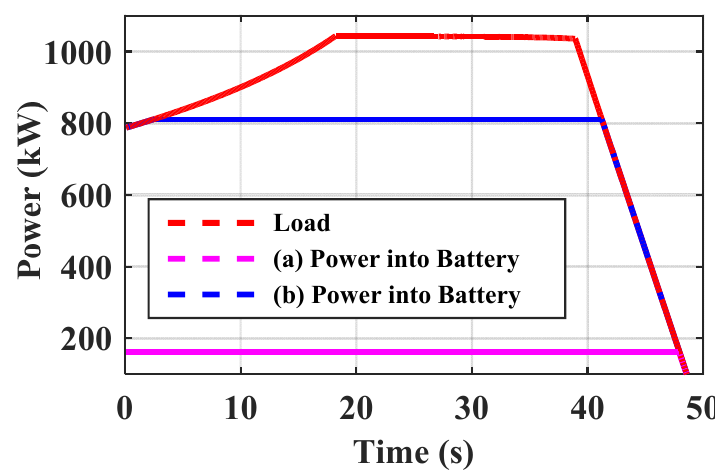
Figure 15. Regenerative power capture by batteries of different sizing ( a ). Rated for maximum load ( b ) Rated for five times of maximum load.